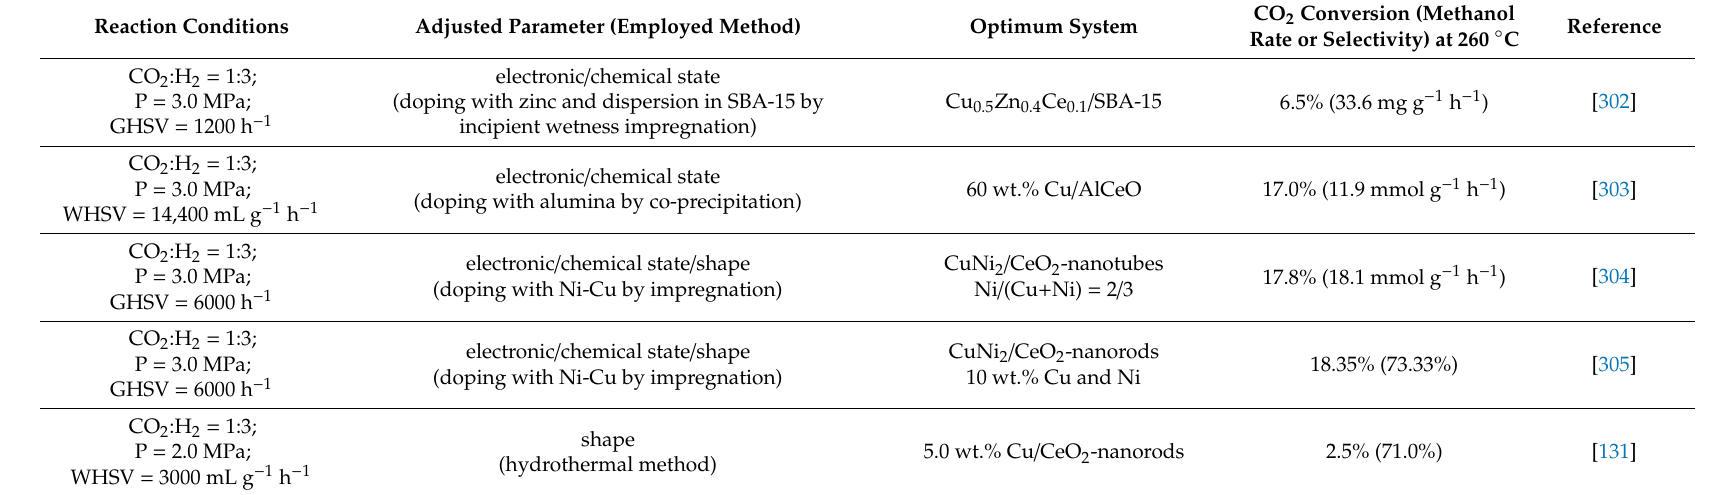
Table 5. Indicative studies towards adjusting the CO 2 conversion to methanol of CuO x / CeO 2